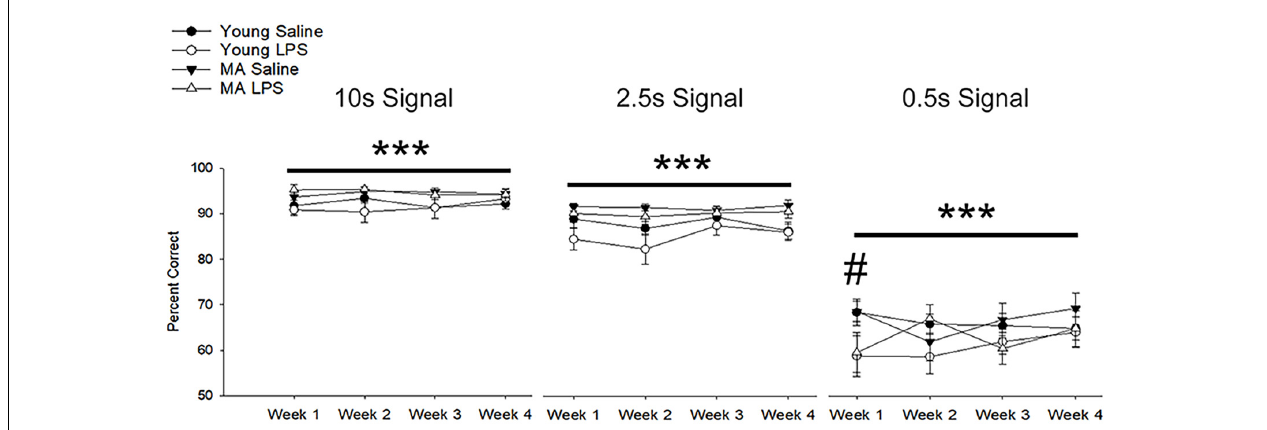
FIGURE 3 | Systemic inflammation impairs attentional accuracy in a signal duration-dependent manner. Young and middle-age rats exhibited a significant signal duration-dependent effect, in which performance accuracy declined as signal duration shortened ( p < 0.001 for all comparisons). Examination of the impact of systemic inflammation on accuracy demonstrated a significant impairment in LPS-treated rats during the first week of treatment on the shortest signal duration, suggesting that inflammation hinders the capacity to attend during conditions of high attentional load. Data are presented as means ± SEM. ∗∗∗ p < 0.001 for main effect of signal duration, # p < 0.05 for treatment interaction.